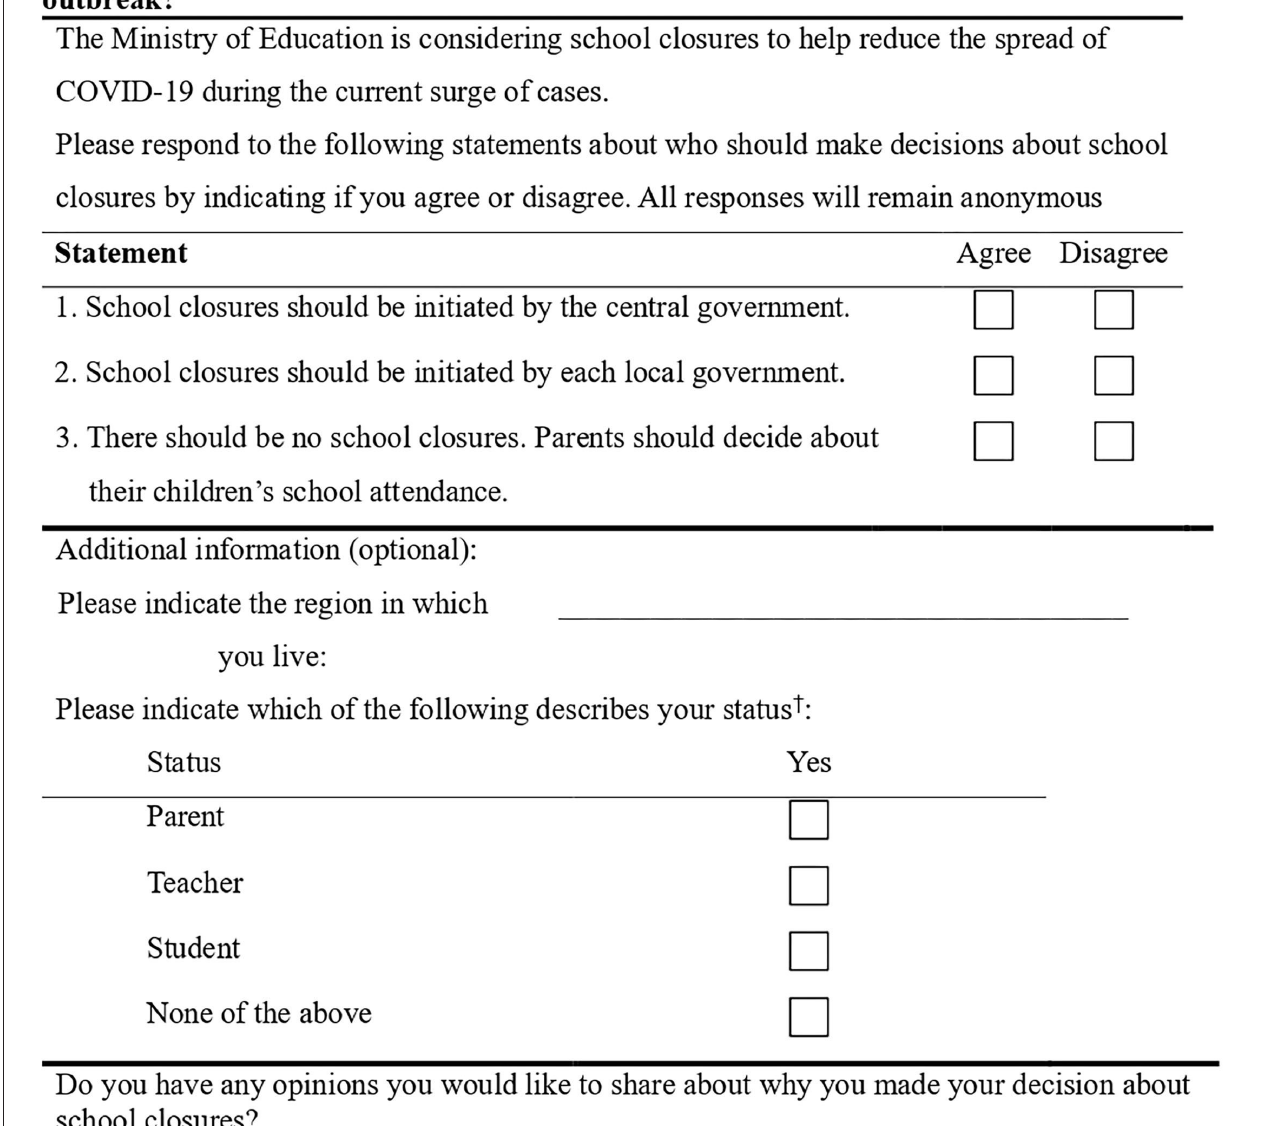
FIGURE 1 | The survey designed by the National Alliance of Parents Organization in Taiwan, “Survey of Opinions of School Closures during the Current COVID-19 Outbreak” (SOSC-COVID-19). † If participants selected “parents” as well as “teacher” or “student”, they were given the status of